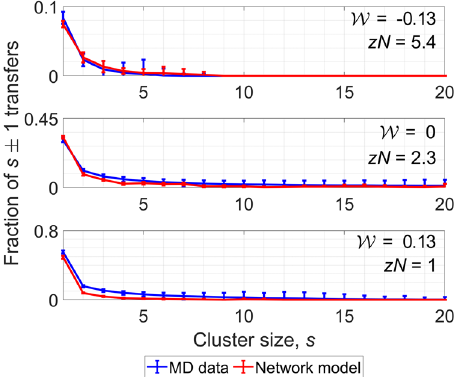
Fig. 8 | Single-molecule transfers between clusters. The distribution of single- molecule transfers peaks for the smallest clusters, especially at high temperatures where no large clusters exist in the supercritical phase. The network model can predict the fraction of single-molecule transfers in supercritical water. The error barsrepresentonestandarddeviation,computedover2500MDtrajectoryframes. Source data are provided as a Source Data fi